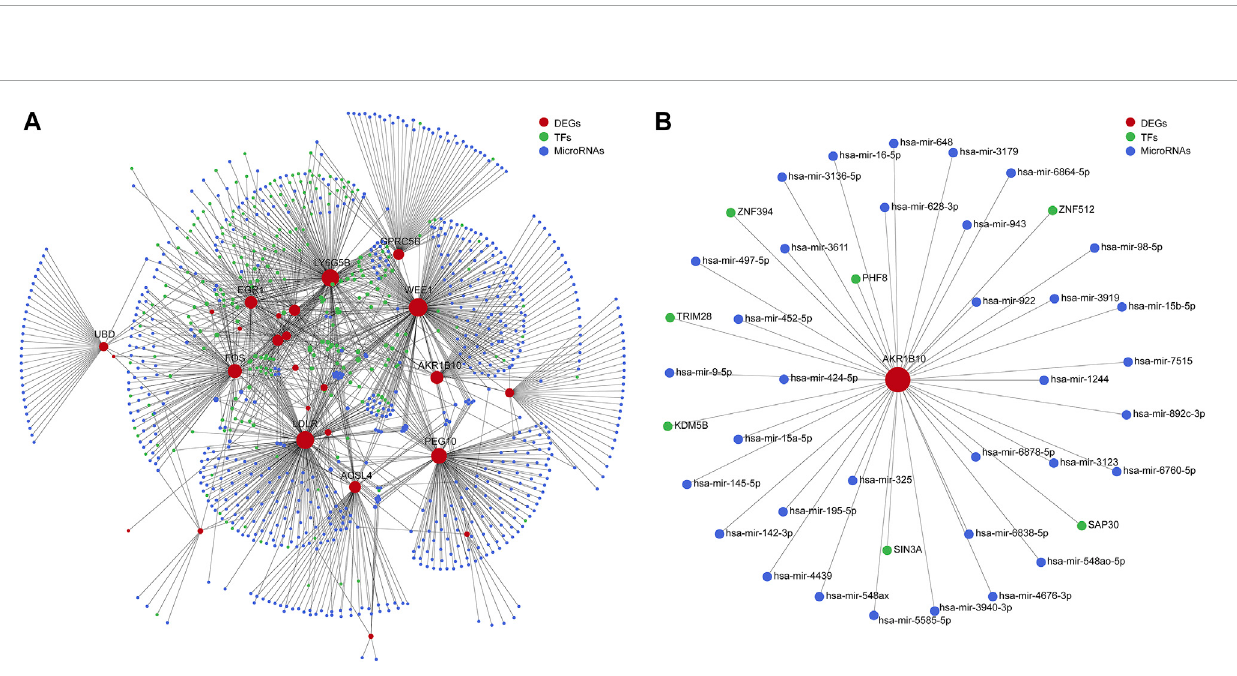
Frontiers in Molecular